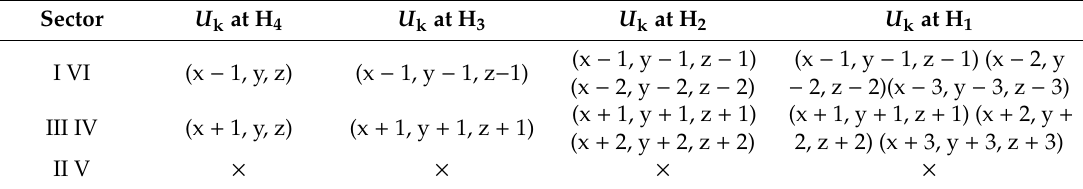
Table 3. Substitution method of voltage vector in the fault state of one unit in phase A.